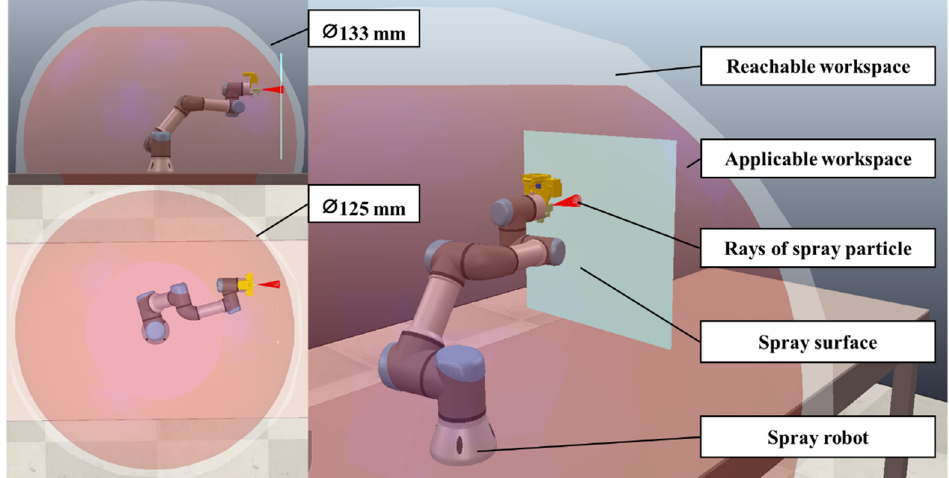
Figure 5. The Workspace of the Robot for the Painting Application.